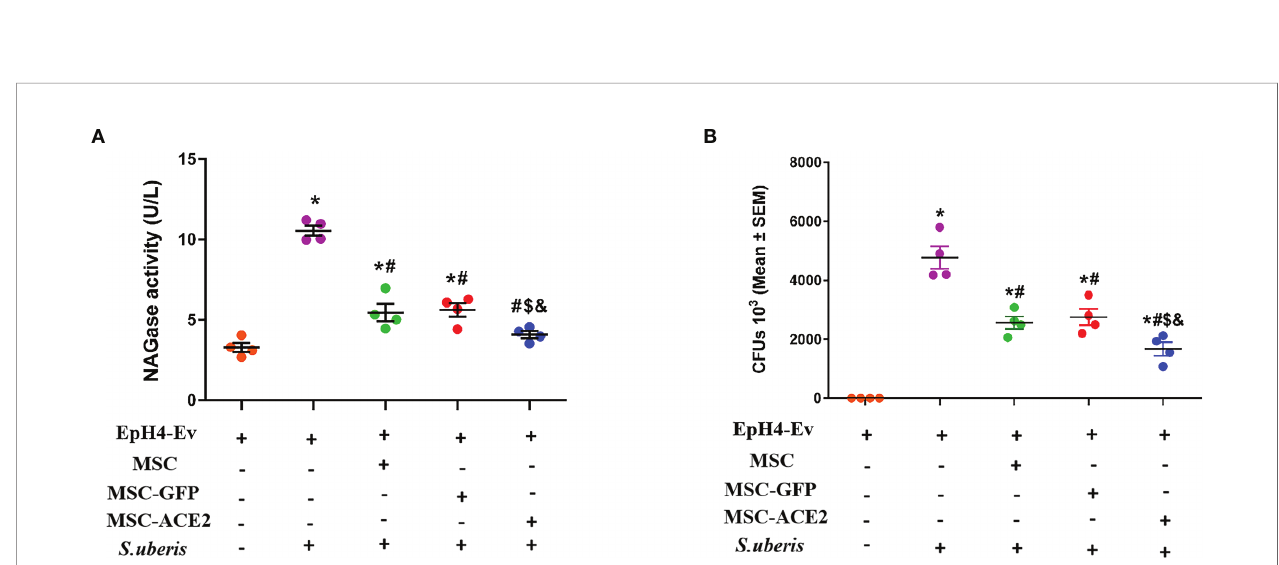
FIGURE 2 | Effect of MSC-ACE2 on NAGase activity and bacterial load in EpH4-Ev cells. (A) Detection of NAGase activity in cell culture supernatant according to kit instructions. (B) The number of S. uberis colonies in EpH4-Ev cells. Experiments were repeated three times and data were presented as the mean ± SEM (n = 4). * P < 0.05 vs. EpH4-Ev; # P < 0.05 vs. S. uberis ; $ P < 0.05 vs. MSC; & P < 0.05 vs. MSC-GFP.